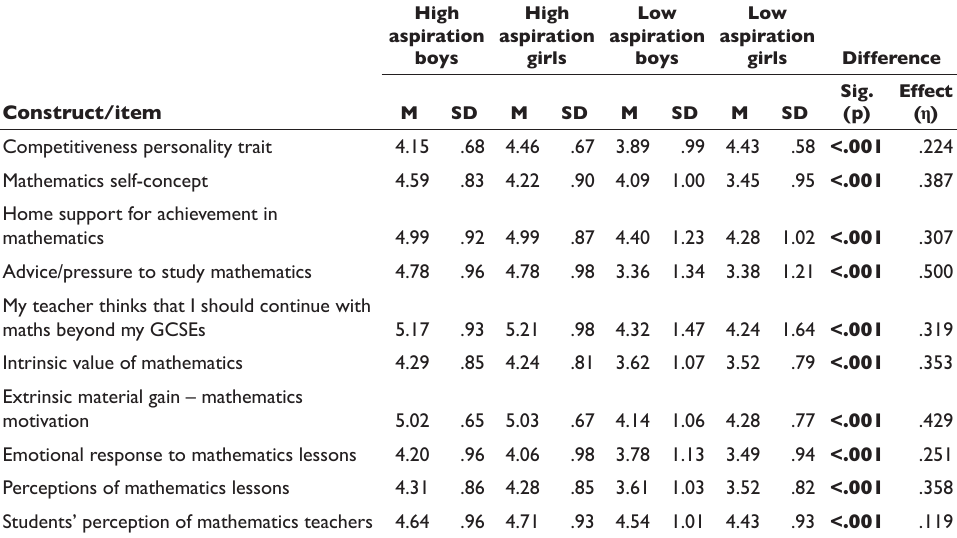
Table 2.2: Londonyear8andyear10students:Girls’andboys’aspirationsinmathematicsandthe relationshipwithotherfactors